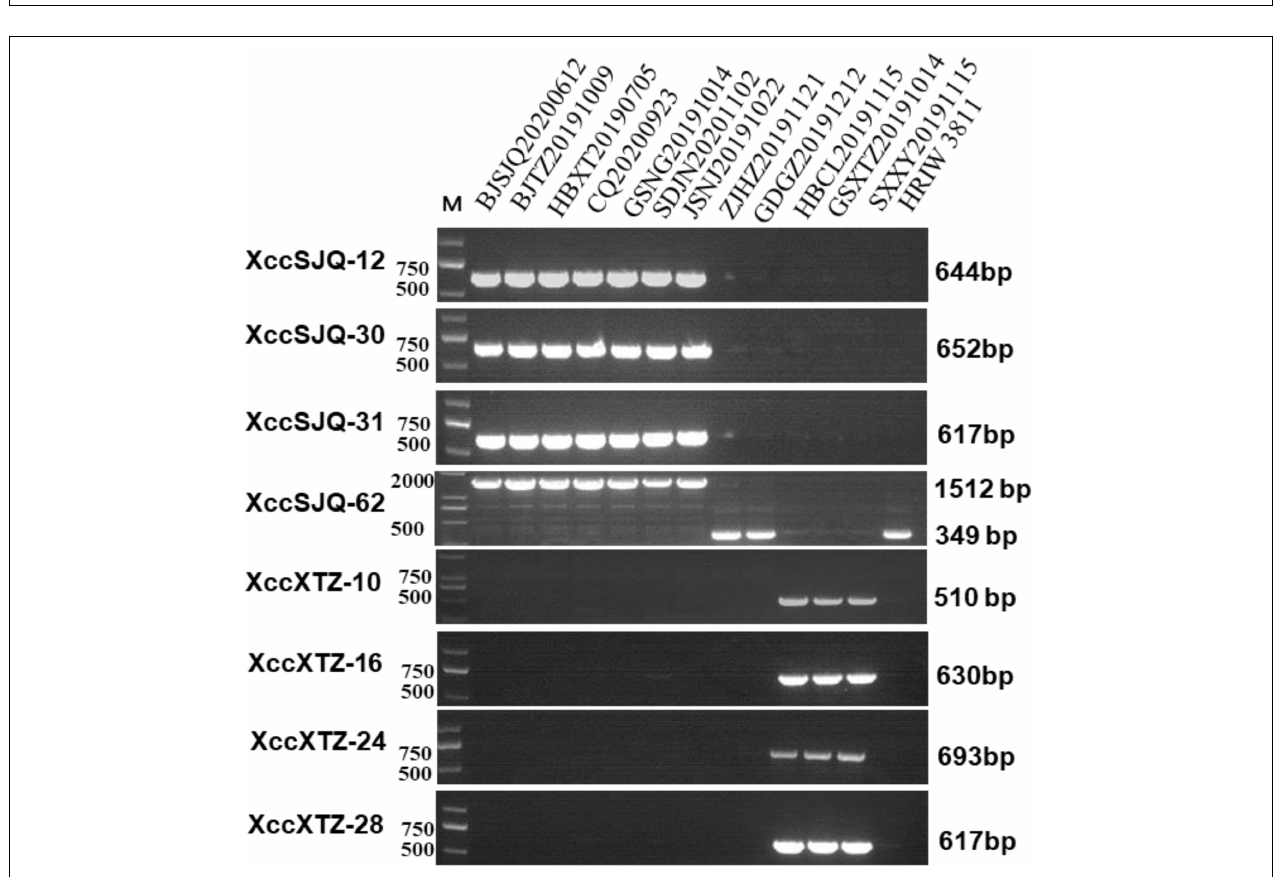
FIGURE 6 | isolate relative to other Xcc strains are set with the line diagram. A 35,024 bp large insertion was located from 101,595 to 136,619 of the genomic sequence. XccXTZ-10-F/R were the GSXT20191014-specific molecular markers. (C) An IS5 family transposase insertion in the GSXT20191014 isolate compared to other Xcc strains are shown with the line diagram. XccSJQ-62-F/R were the BJSJQ20200612-specific molecular marker. The GenBank accession numbers are NZ_CP025750 for HRIW 3811, AM920689 for B100, NZ_CM002545 for CFBP 1869, AE008922 for ATCC 33913, NZ_CM002673 for CFBP5817 and NC_007086 for Xcc 8004, respectively. (D) The usability of molecular markers XccSJQ-62 and XccXTZ-10 were tested by PCR using the genomic DNA of Xcc strains (HRIW 3811, HRIW 3849A, HRIW 5212, HRIW 1279A, HRIW 3880, HRIW 6181, and Xcc 8004). DNA concentration of all samples was 50 ng/ µ l. Lane M: 2k plus DNA ladder was used as the size marker. BJSJQ20200612 and GSXT20191014 were used as the positive control on the upper and lower panel, respectively.